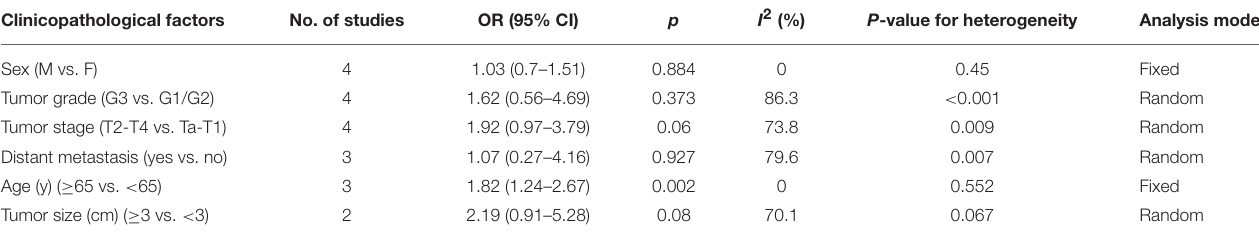
TABLE 3 | Meta-analysis results of PLR and clinicopathological parameters in patients with bladder cancer.